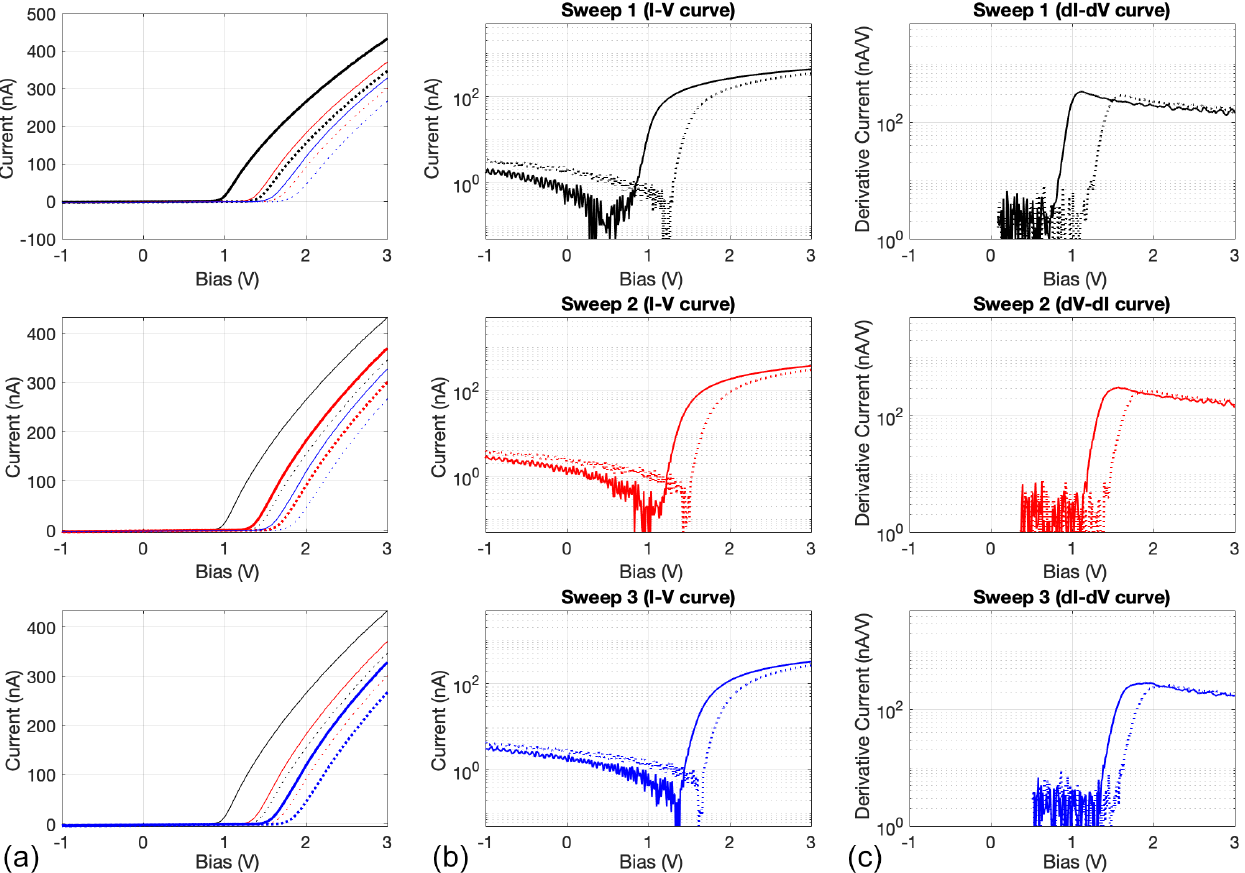
Figure 15. I-V characteristics of three consecutive two-way sweeps measured in the laboratory plasma chamber when the S/C GND is connected to the chamber chassis (zoom of the − 1 to + 3V bias range). The increasing and decreasing parts of the sweeps are in solid and dashed lines, respectively. The first, second and third sweeps are in blue, red and black, respectively. (a) The three consecutive two-way sweeps with the first, second and third sweeps in bold in the top, middle and bottom panels, respectively (linear scale). (b) First, second and third sweeps in the top, middle and bottom panels, respectively (semi-log scale). (c) First derivative of the current for the first, second and third sweeps in the top, middle and bottom panels, respectively (semi-log